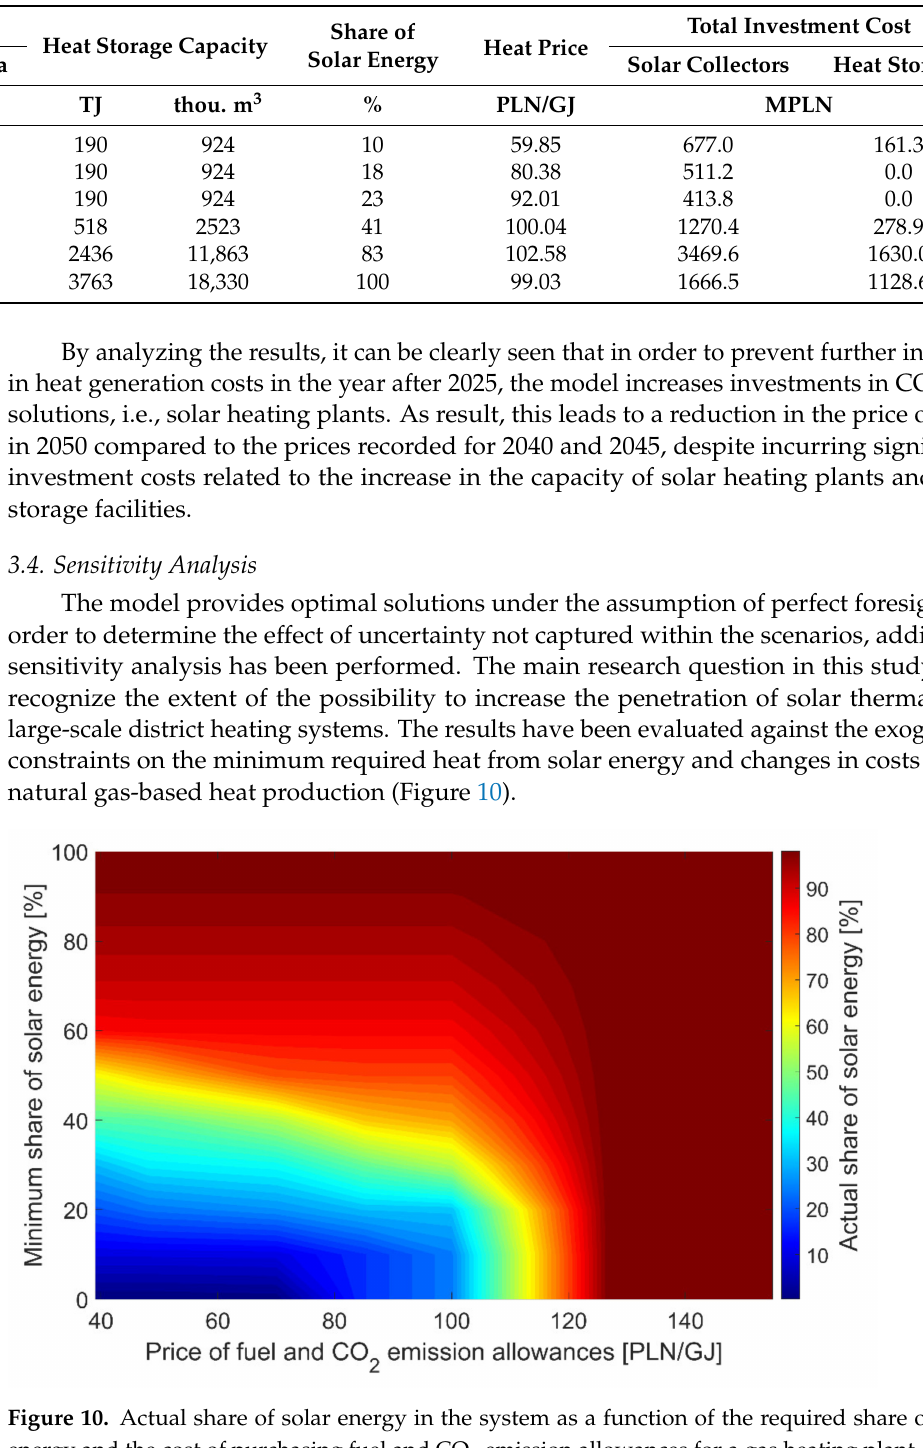
Table 14. Summary of the basic results of the DYN scenario in subsequent years.